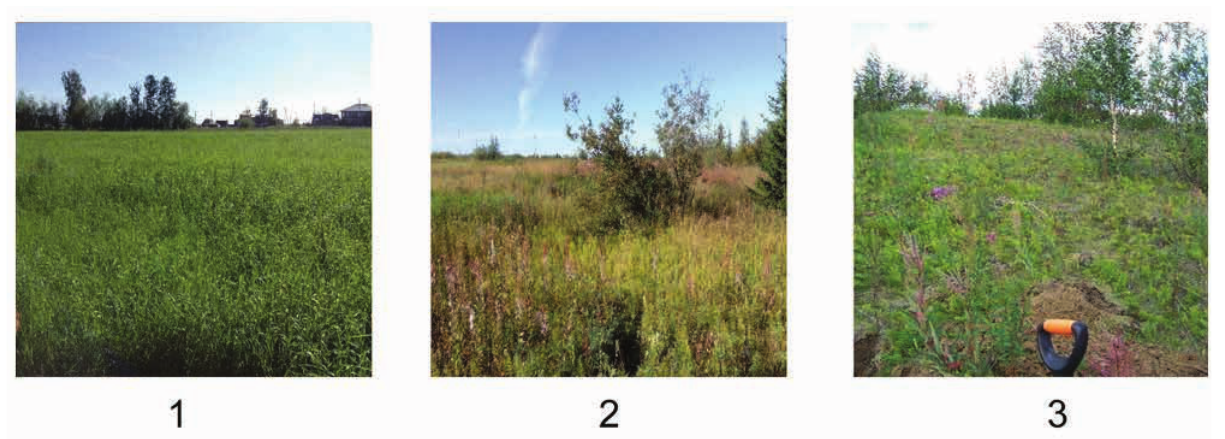
Figure 1: Study plots in the Yamal autonomous region (West